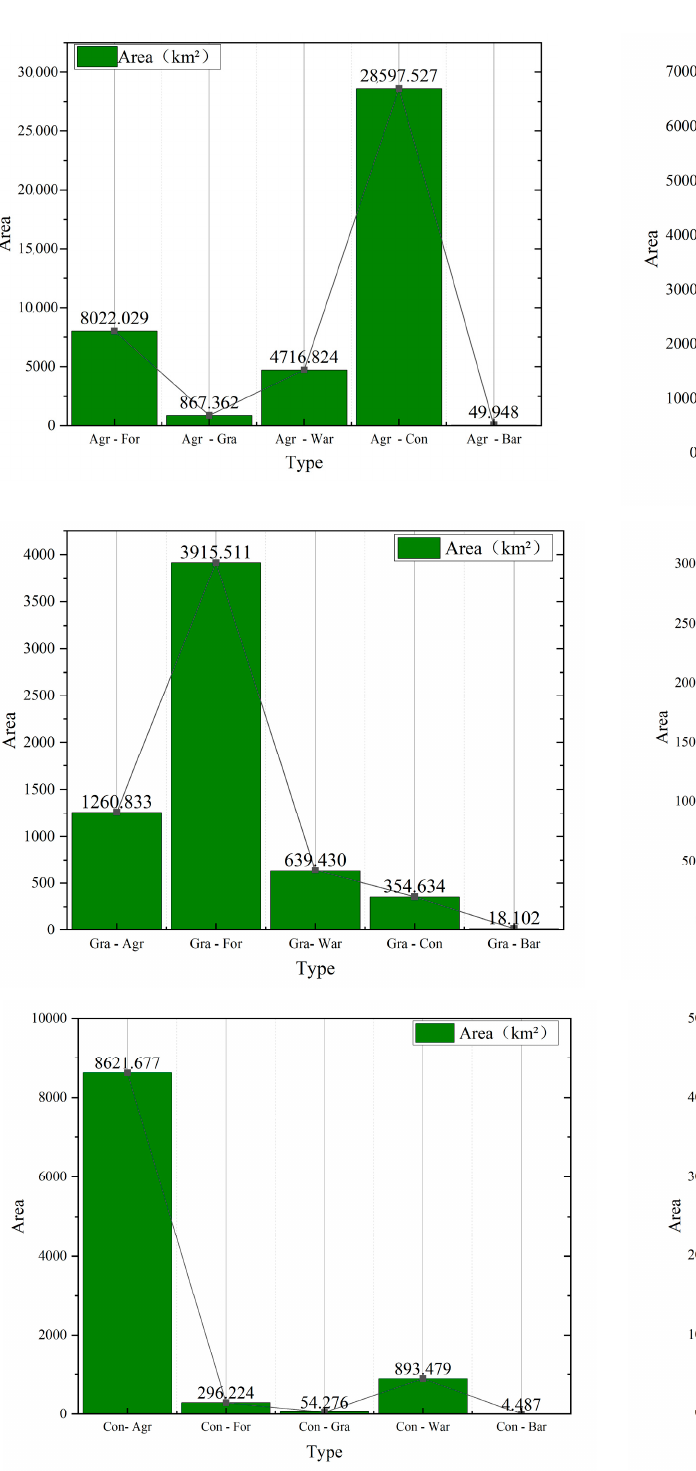
Figure A2. Spatial distribution of topographic potential index in the Yang tz e River Delta.